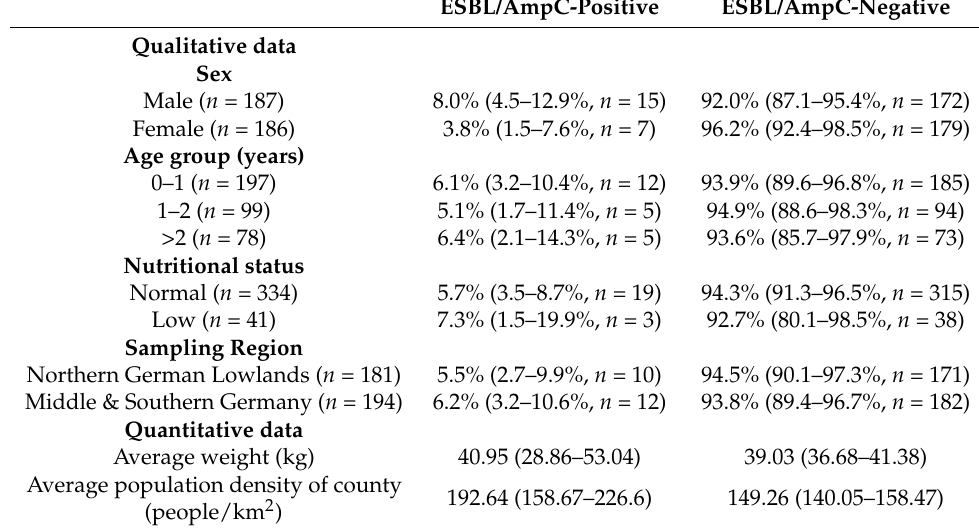
Table 1. Observed frequencies of qualitative characteristics and averages of quantitative attributes of Extended-spectrum β -lactamase (ESBL)- and AmpC β -lactamase-positive and -negative wild boars and their respective harvesting